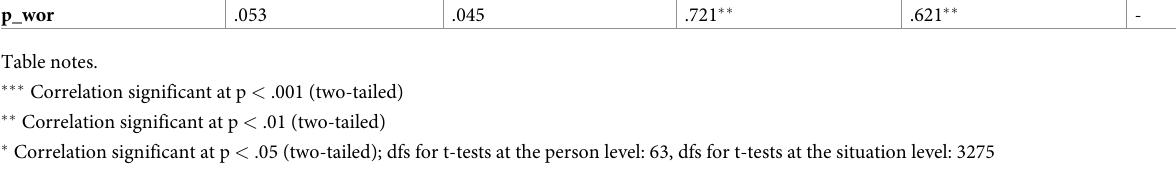
Table notes. ��� Correlation significant at p < .001 (two-tailed) �� Correlation significant at p < .01 (two-tailed) � Correlation significant at p < .05 (two-tailed); dfs for t-tests at the person level: 63, dfs for t-tests at the situation level: